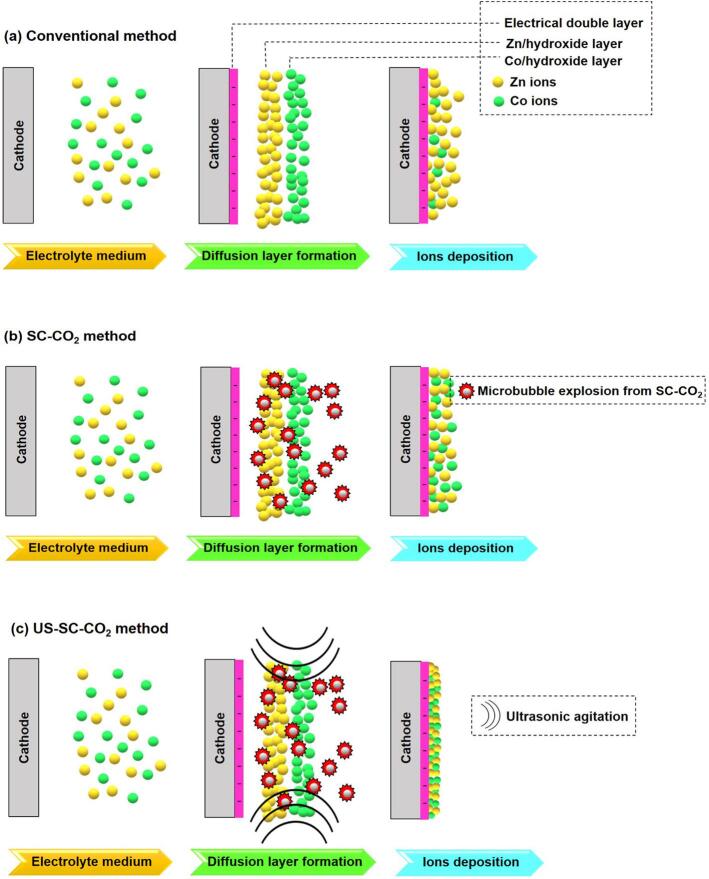
Schematic representation of possible film growth mechanism.